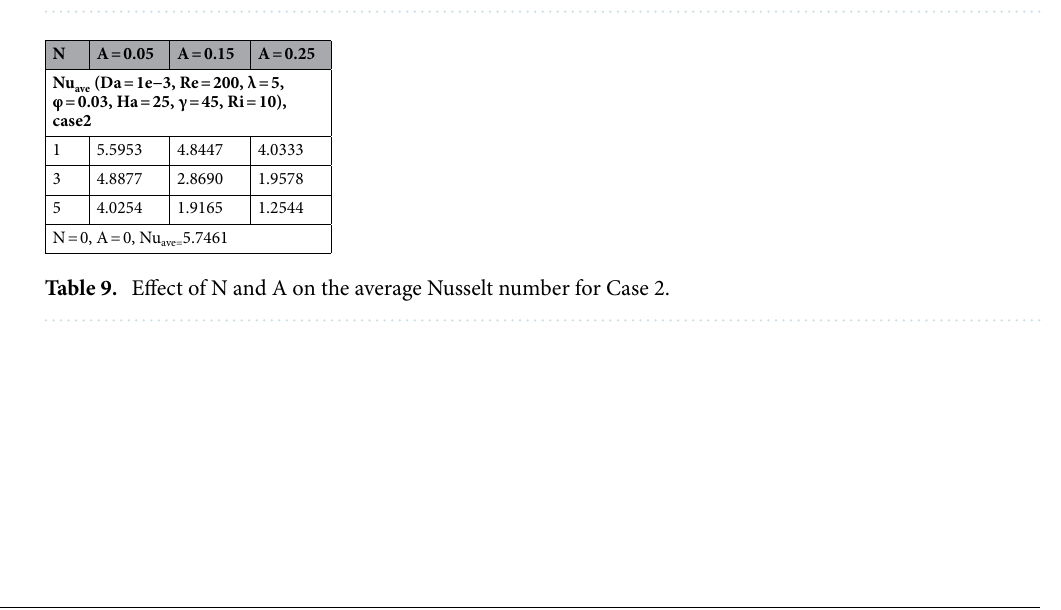
Figure 10. Isotherm, streamlines, Bejan number and Sgen at different Re numbers when Da = 1e−2, A = 0.15, Ha = 20, γ = 45, Ri = 100, γ = 45, φ = 0.03, λ = 5, N = 3 for Case 1.